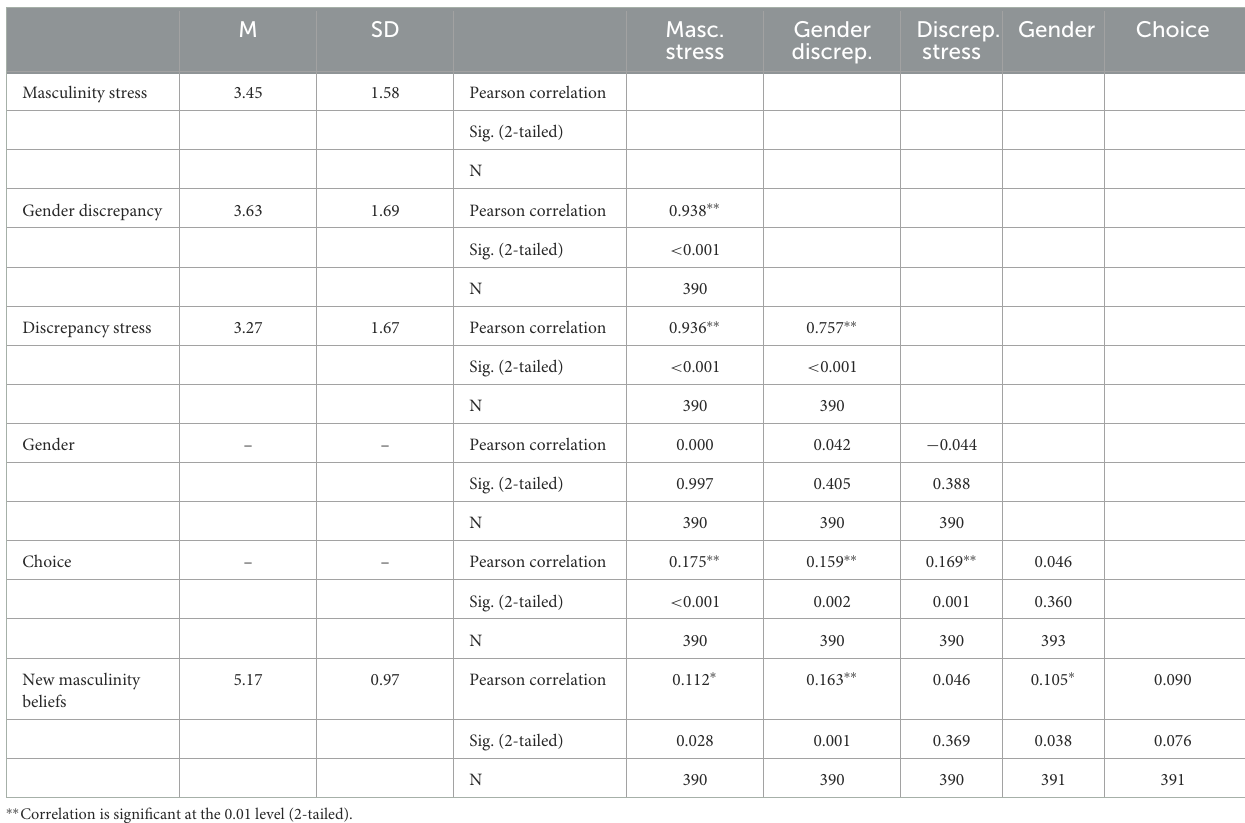
TABLE 3 Study 2 descriptives and zero-order intercorrelations.